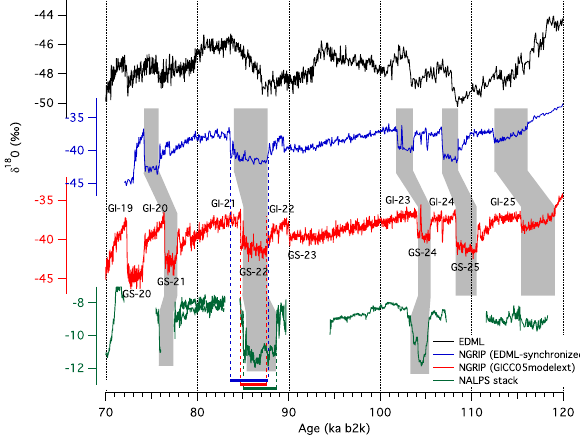
Fig. 1. Comparison of temperature proxy records from Greenland, Europe and Antarctica. The Antarctic EPICA Dronning Maud Land (EDML) ice core δ 18 O ice record is shown in black (EPICA commu- nity members, 2006). The Greenland NorthGRIP ice core δ 18 O ice record is shown in blue ( NGRIP-EDML gas-synchronized chronol- ogy, Capron et al., 2010b) and red ( GICC05modelext chronology, Wolff et al., 2010). The Northern Alps (NALPS) speleothem record is shown in green (Boch et al., 2011). Colored markers at the bot- tom of the graph show the different timings and durations of GS-22 according to each archive and